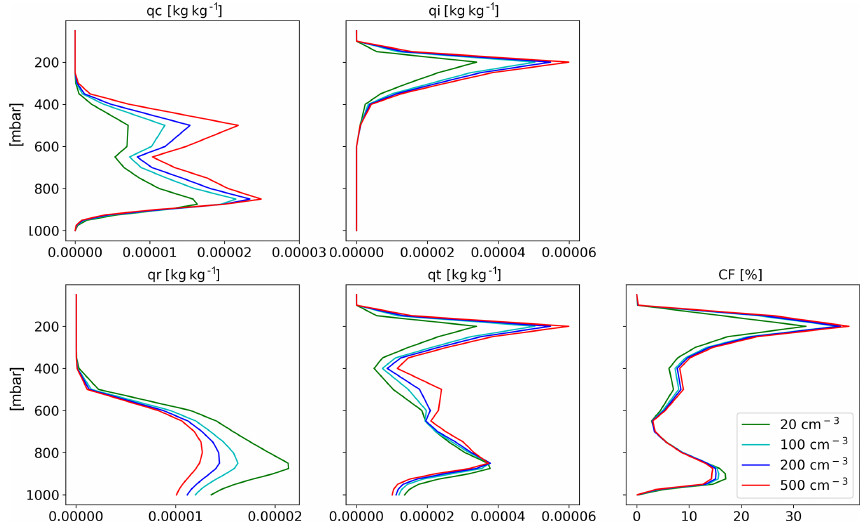
Figure 17. Domain- and time-average vertical profiles for the different CDNC simulations for the shallow-cloud-dominated case. The prop- erties that are presented here are as follows: cloud droplet mass mixing ratio (qc – for clouds’ drops with radius smaller than 40µm), ice mass mixing ratio (qi), rain mass mixing ratio (qr – for clouds’ drops with radius larger than 40µm), total water mass mixing ratio (qt = qc + qi + qr) and cloud fraction